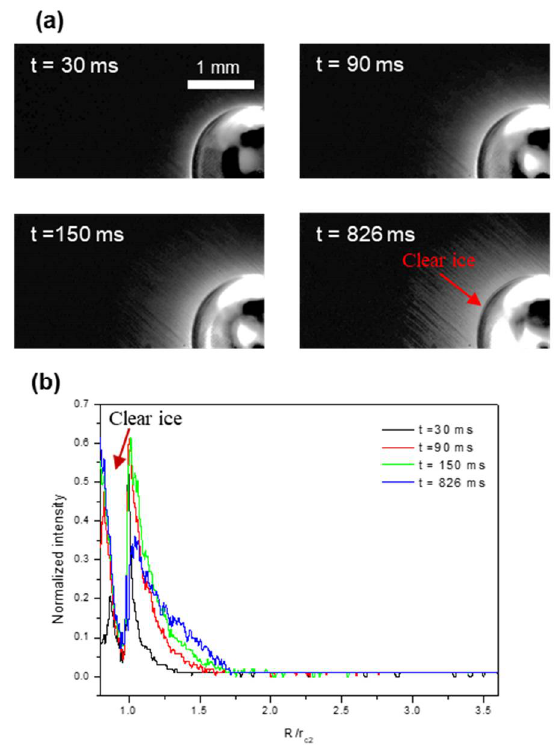
Figure 6. Growing dynamics of condensate/frost region ( a ) and the resultant intensity profiles ( b ) at the substrate temperature of T s = −22.1 ± 0.2 °C.